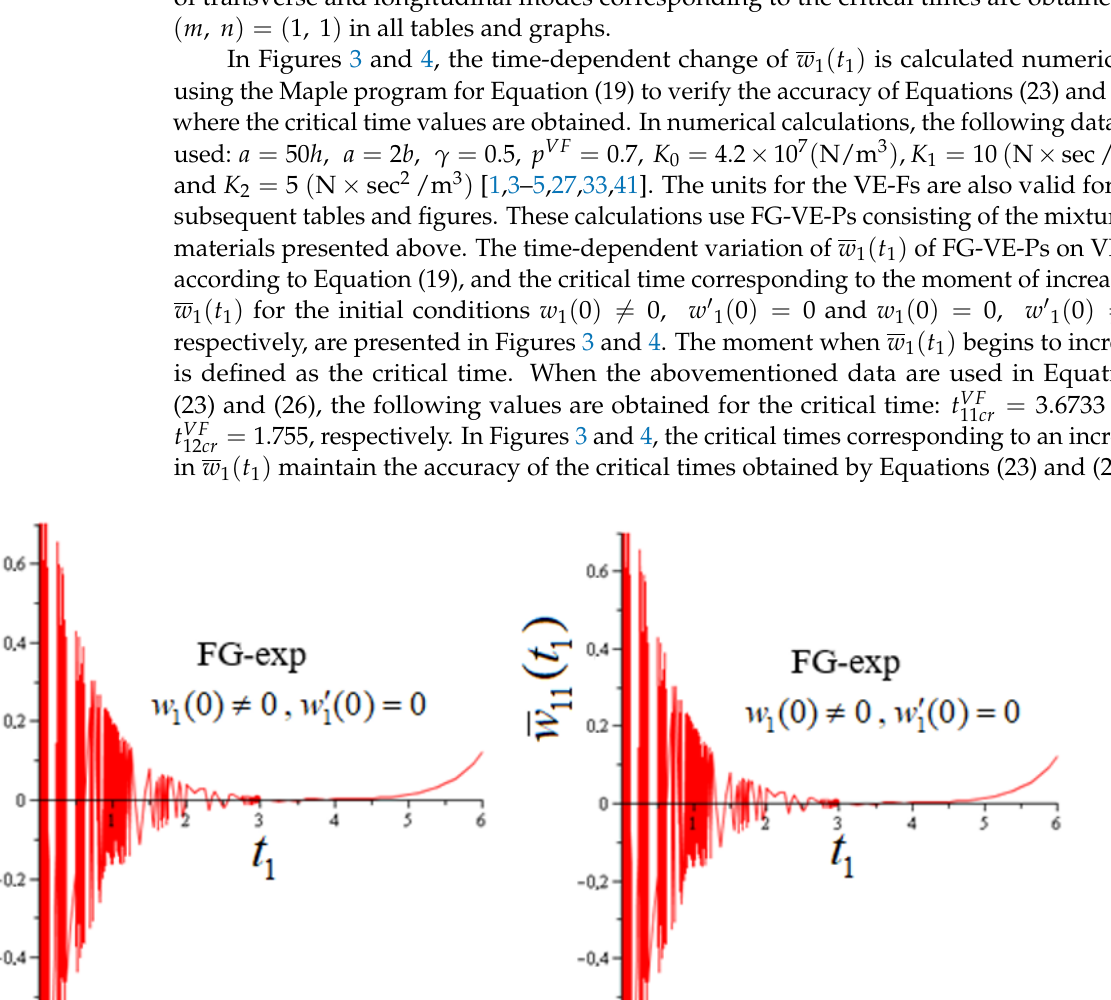
Figure 4. Variation of the deflection of FG-VE-Ps on VE-Fs according to Equation (19) for the initial conditions